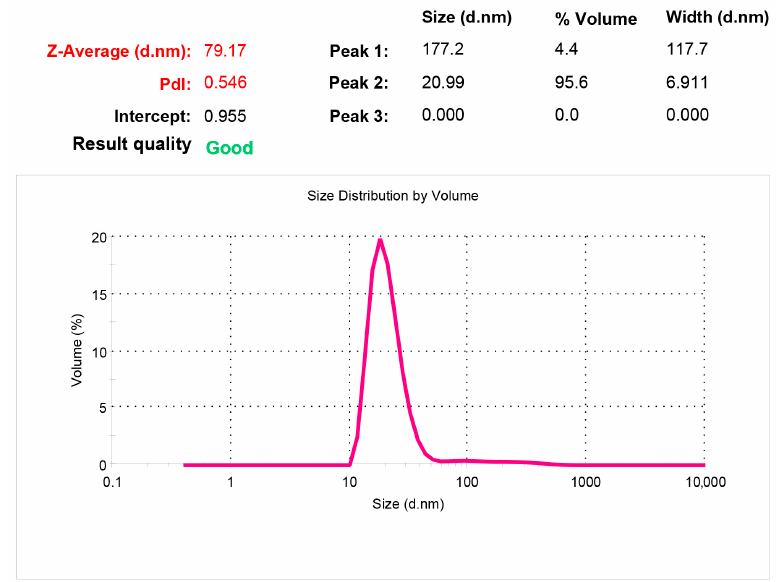
Figure 2. Dynamic light scattering spectrogram characterizing the polydisperse distribution of particle sizes by volume in a freeze-dried Indolip sample after its reduction in water. Table 1. Characteristics of indomethacin composition before and after drying.